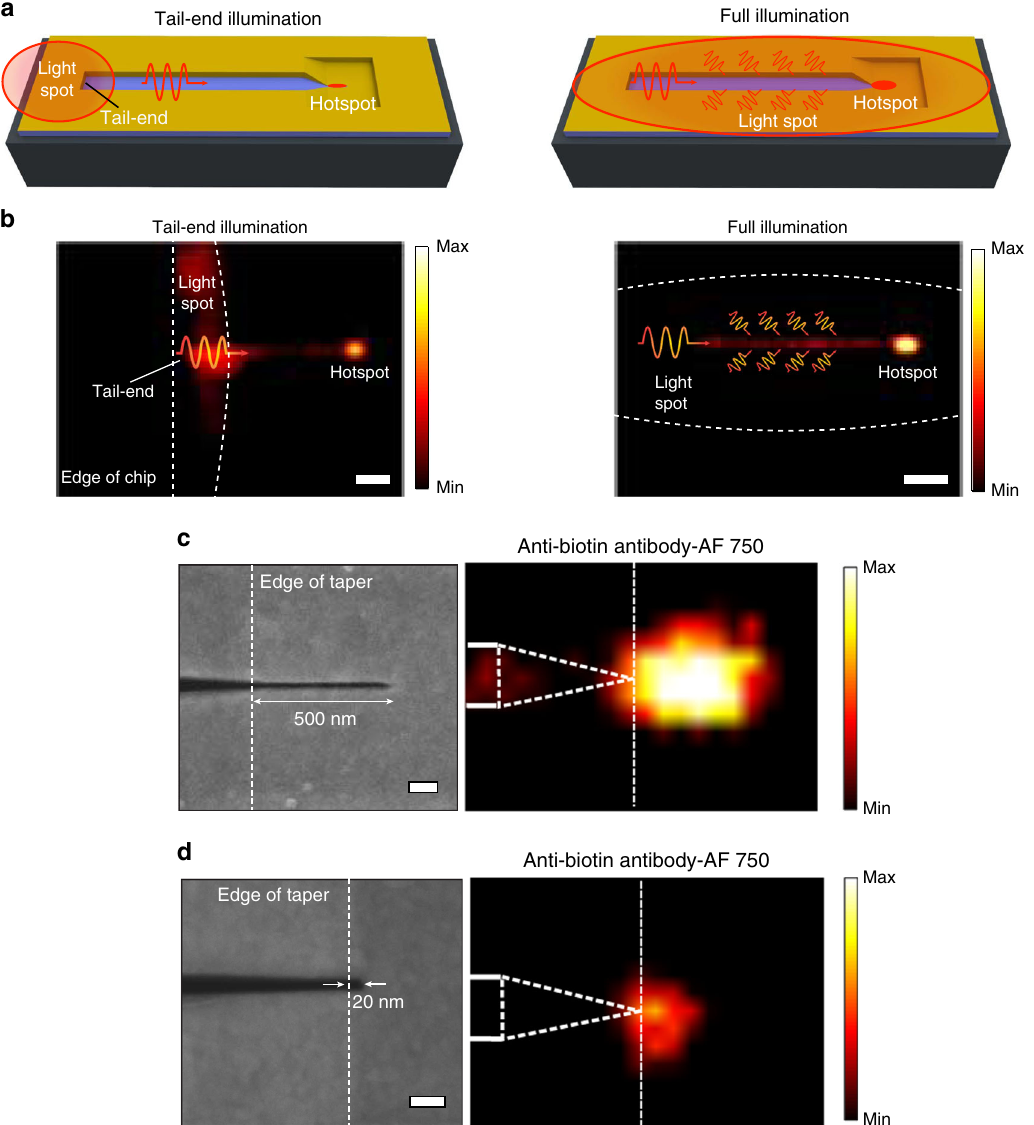
Fig. 3 Molecular fl uorescence enhancement and single molecule capture. a Illustration and b fl uorescence images of streptavidin capture inside the nanocavities using tail-end (left) as well as full (right) illumination modes. Hotspot is visible at the end of taper within the 20 nm-wide tip. Scale bars are 1 µ m. c SEM image (left) of a 3D-tapered nanocavity with tip length 500 nm and fl uorescence image (right) obtained from the tip after antibody immobilization. 1D-array of antibodies is expected within the tip. Scale bar is 100 nm. d SEM image (left) of a 3D-tapered nanocavity tip with length 20 nm and fl uorescence image (right) obtained from the short tip after antibody immobilization. Volumetric-limitation enables speci fi c capture of single antibody at the end of the tip. Scale bar is 100